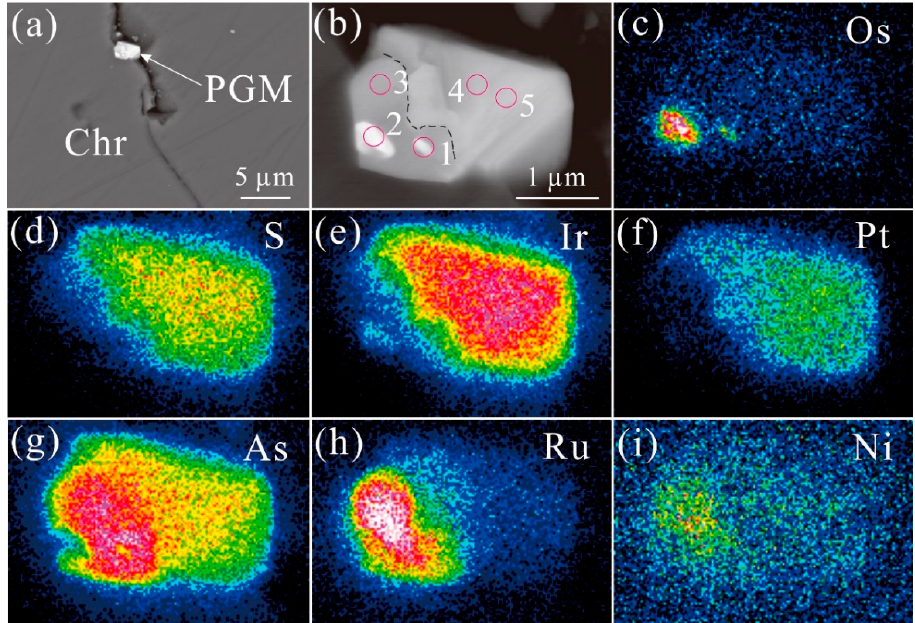
Figure 4. BSE images and S, As, Ir, Ru, Pt, Os, and Ni element maps of a three-phas PGM grain from the chromite fracture. ( a , b ) BSE images; ( c – i ) Os, S, Ir, Pt, As, Ru, and Ni element maps. Chr: chromite; numbers represent-the positions of semi-quantitative spot analyses listed in Table 1.